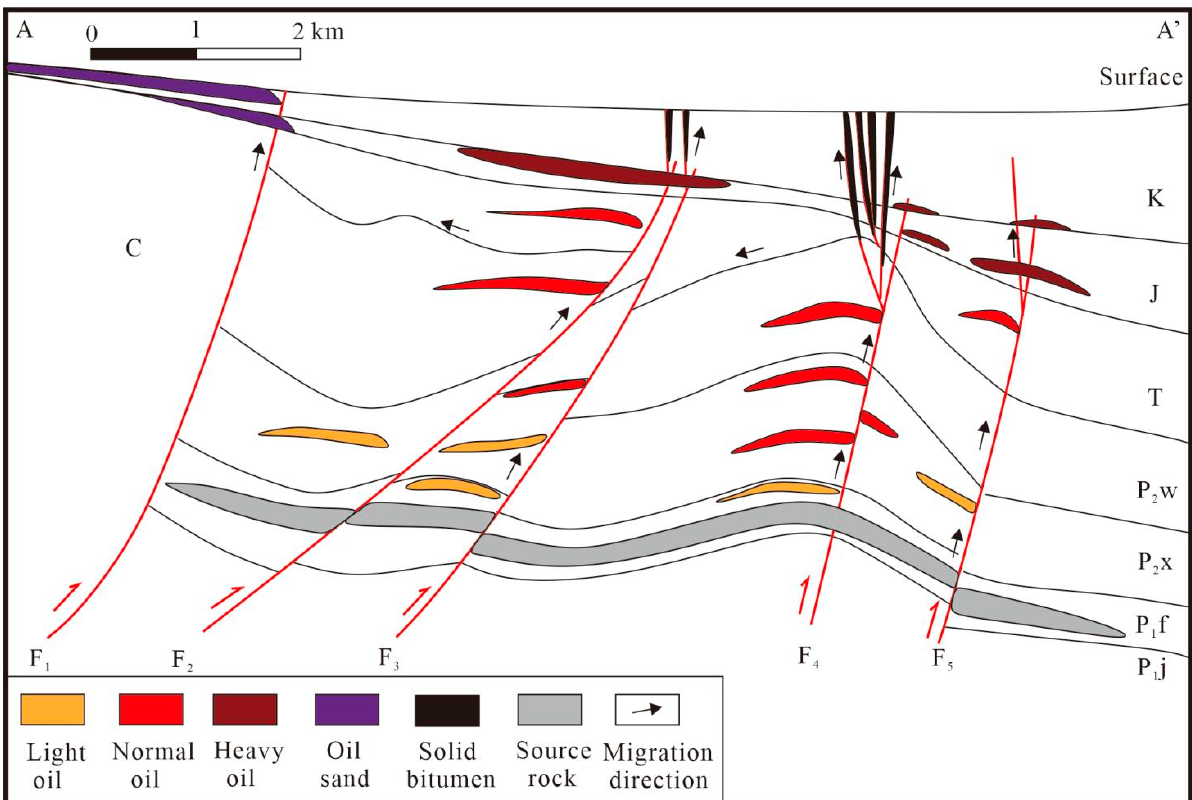
Figure 10. Multi-layer reservoir formation model in Wuerhe area, showing the Permian source rocks, the Permian–Triassic light oil reservoir, the Jurassic heavy oil reservoir, the Cretaceous oil sand, and the bitumen from bottom to top. Five reverse faults (F 1 –F 5 ) were developed from the Halalarte mountain to the Mahu depression.